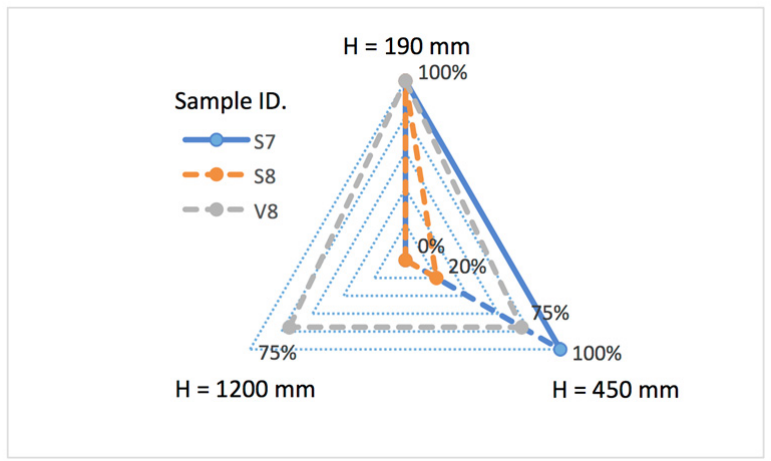
Fig. 4 Percentage of specimens passing unbroken the impact test at different drop height